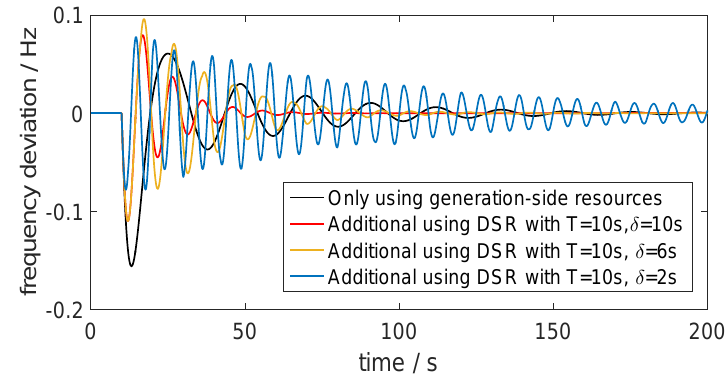
Figure 6. Frequency deviation of area 1 under different intermittent control